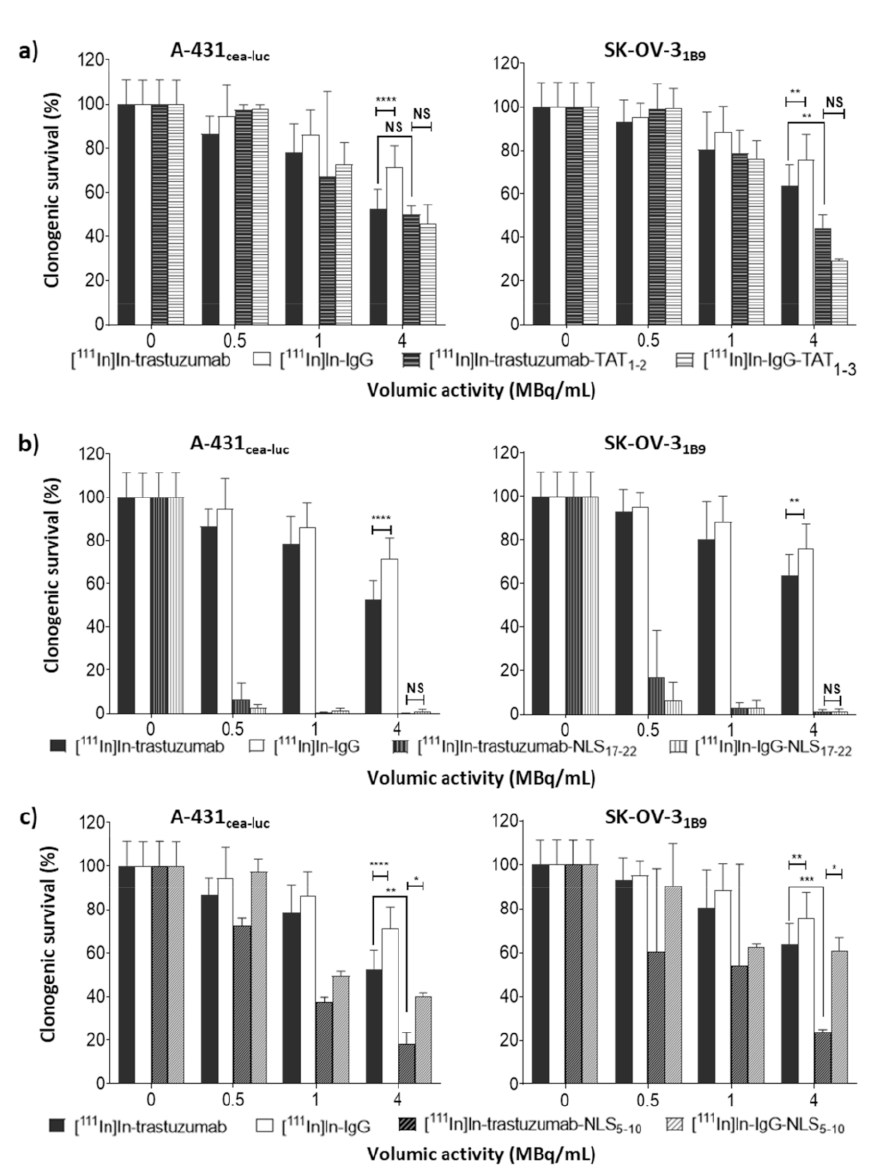
Figure 3. In vitro clonogenic cell death of radioimmunoconjugates. Clonogenic survival was as- sessed in A-431 CEA-luc and SK-OV-3 1B9 cells 12 days after a 48 h exposure to [ 111 In]In-trastuzumab or [ 111 In]In-IgG, and ( a ) [ 111 In]In-trastuzumab-TAT 1-3 or [ 111 In]In-IgG-TAT 1-3 ; ( b ) [ 111 In]In- trastuzumab-NLS 17-22 or [ 111 In]In-IgG-NLS 17-22 ; ( c ) [ 111 In]In-trastuzumab-NLS 5-10, or [ 111 In]In-IgG- NLS 5-10 (0–4 MBq/mL; 0–10.8 µ g/mL). Data are the mean ± SD. Experiments were performed at least three times in triplicate. * p ≤ 0.05, ** p ≤ 0.01, *** p ≤ 0.001, **** p ≤